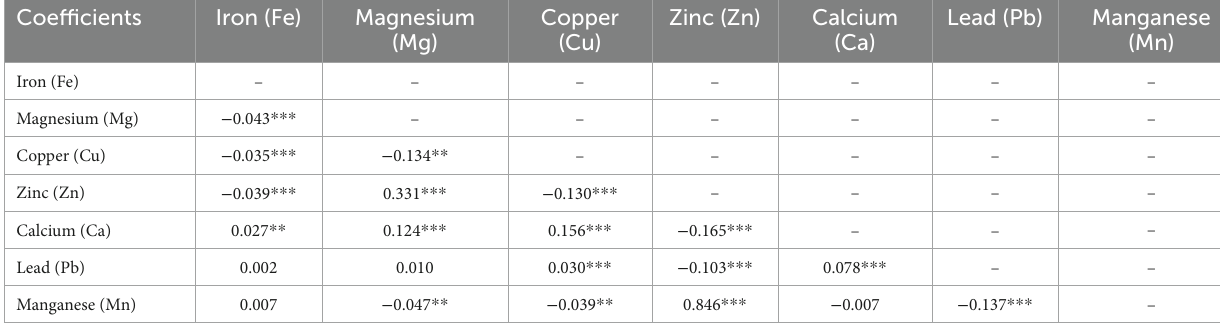
TABLE 2 Spearman correlation between the serum metal concentrations.